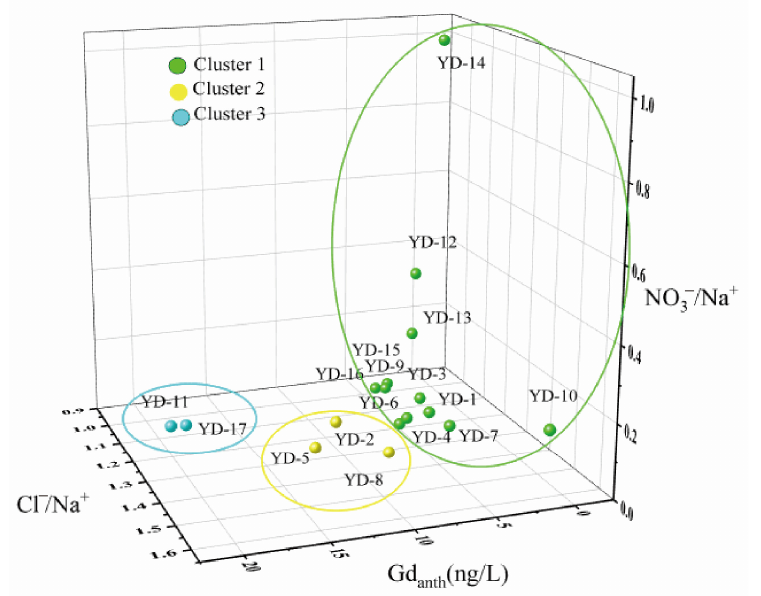
Figure 7. The cluster results of water samples using Gd anth , NO 3 − /Na + and Cl − /Na + as co-indicators in the Yongding River basin.